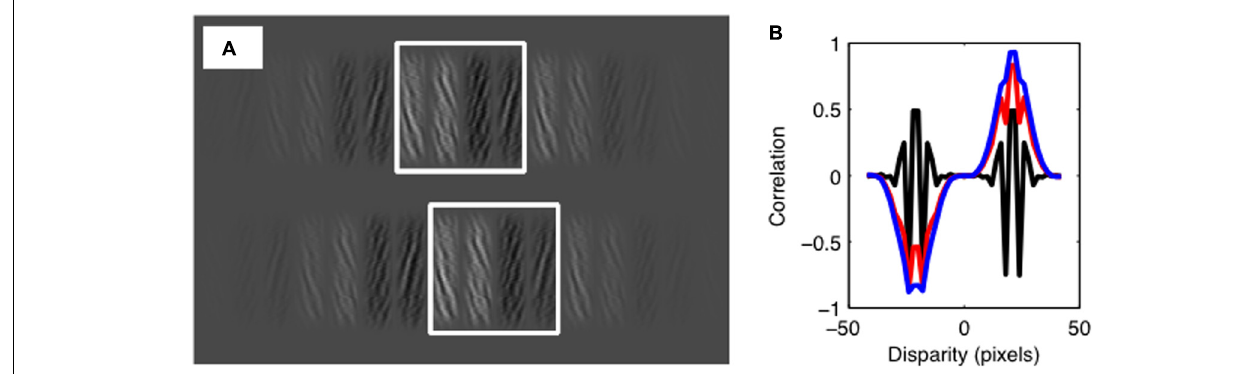
with no luminance bias. This shows peaks in the correlation function of equal magnitude for crossed and uncrossed disparities. Outputs are also shown for a luminance bias of 0.25 (red line) and 0.5 (blue line). As the luminance bias increases, the correlation increases for one sign of disparity, and decreases for the other. Note that, although the output of the correlation model is shown here at a range of disparities, the decision stage of the model only considers disparities consistent with the periodic structure of the